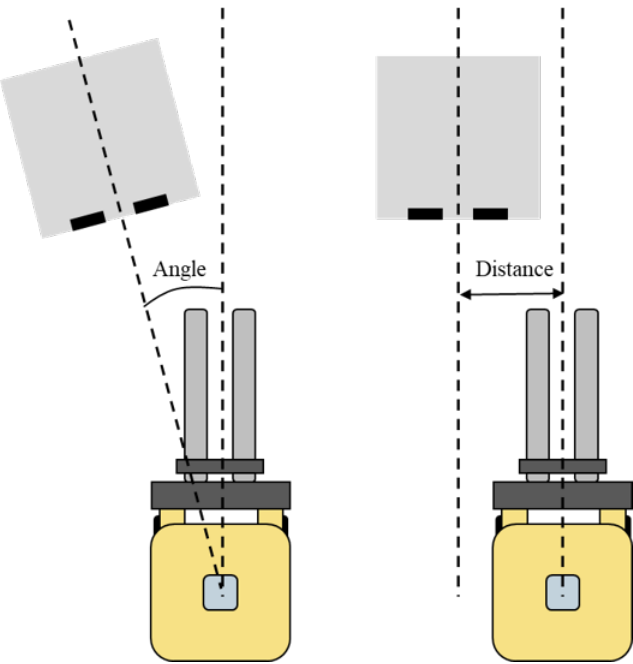
Figure 3. Definition of two classes: angle,